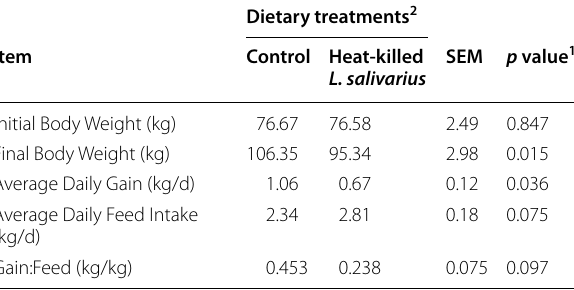
Table 2 Effect of heat-killed L. salivarius on the growth performance of finishing